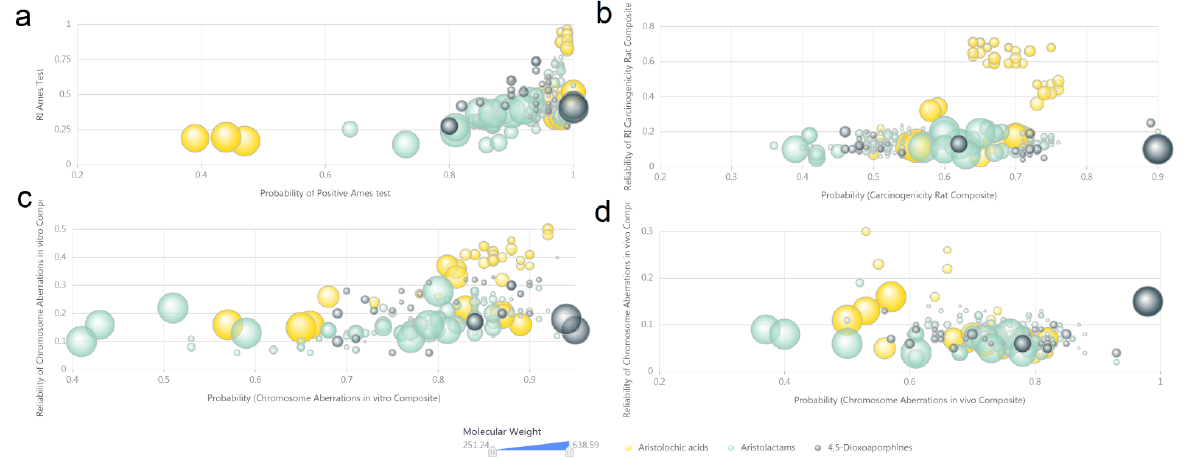
Figure 9. The scatter plot of computer predicted genotoxicity of aristolochic acid analogues. ( a ) Probability of positive Ames test. ( b ) Probability of carcinogenicity rodent composite. ( c ) Probability of chromosome aberrations in vitro composite. ( d ) Probability of chromosome aberrations in vivo composite. High-resolution image file of this figure can be found in Supplementary Materials as Figure S7.